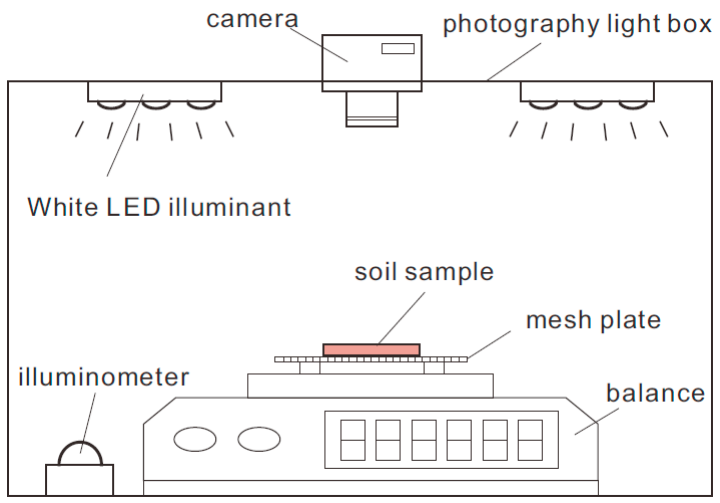
Figure 4. Schematic view of air-dry test